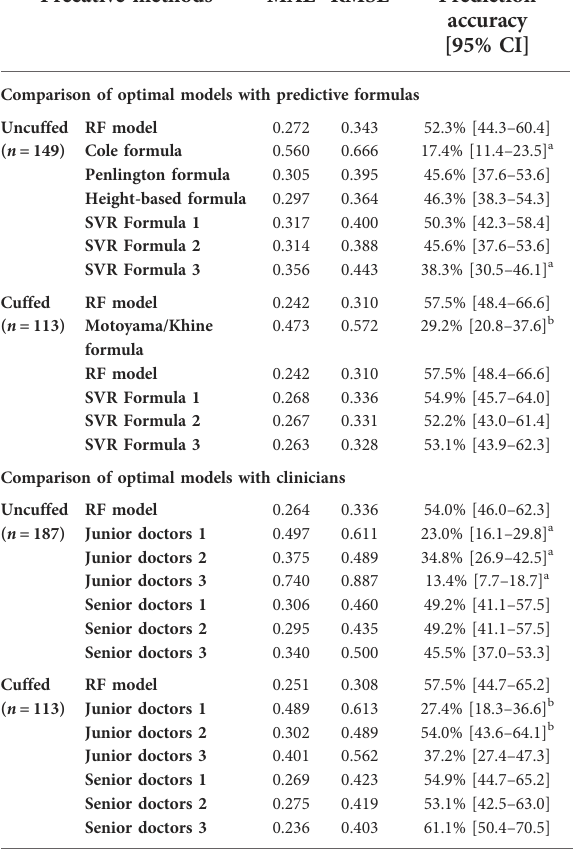
TABLE 2 Validation of performance of the optimal machine learning models. Precative methods MAE RMSE